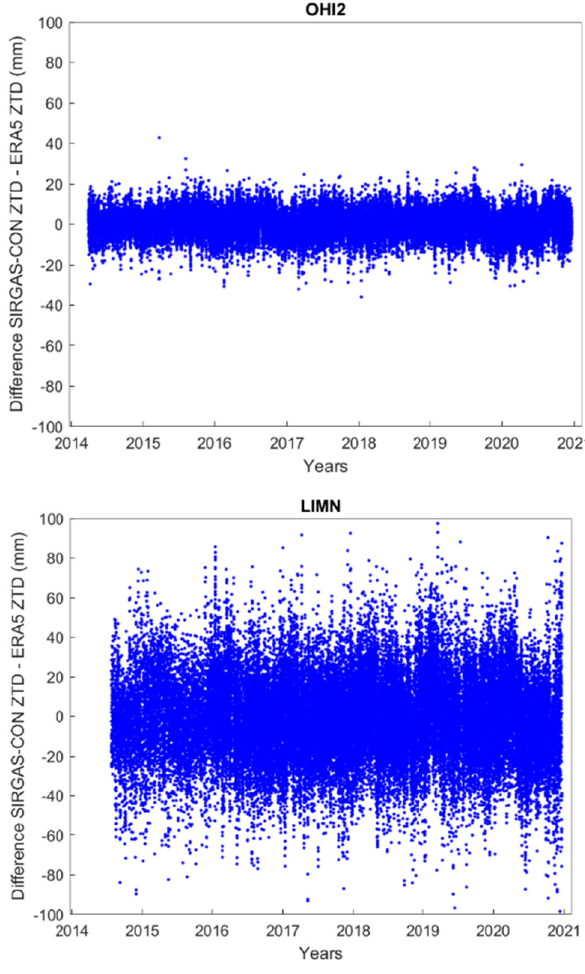
Figure 6: SIRGAS - CON ZTD and ERA5 ZTD di ff erences for stations ( a ) OHI2 and ( b ) LIMN.